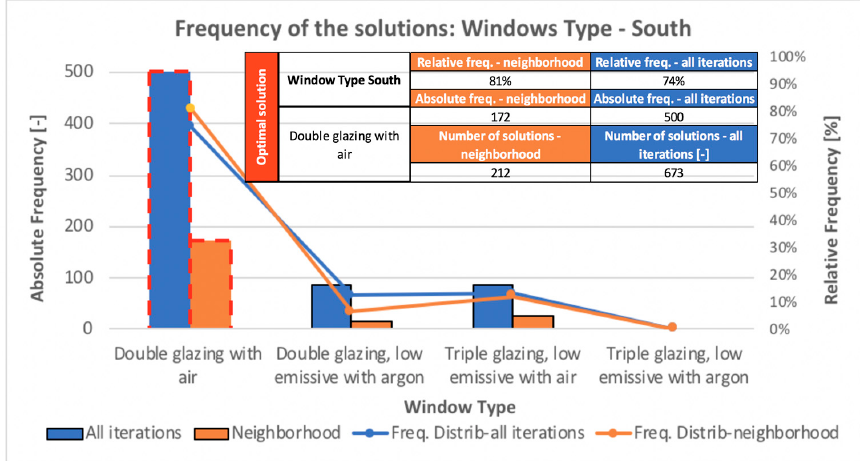
Figure 8. Robustness profile: window type, south; financial objective, sequential optimization.